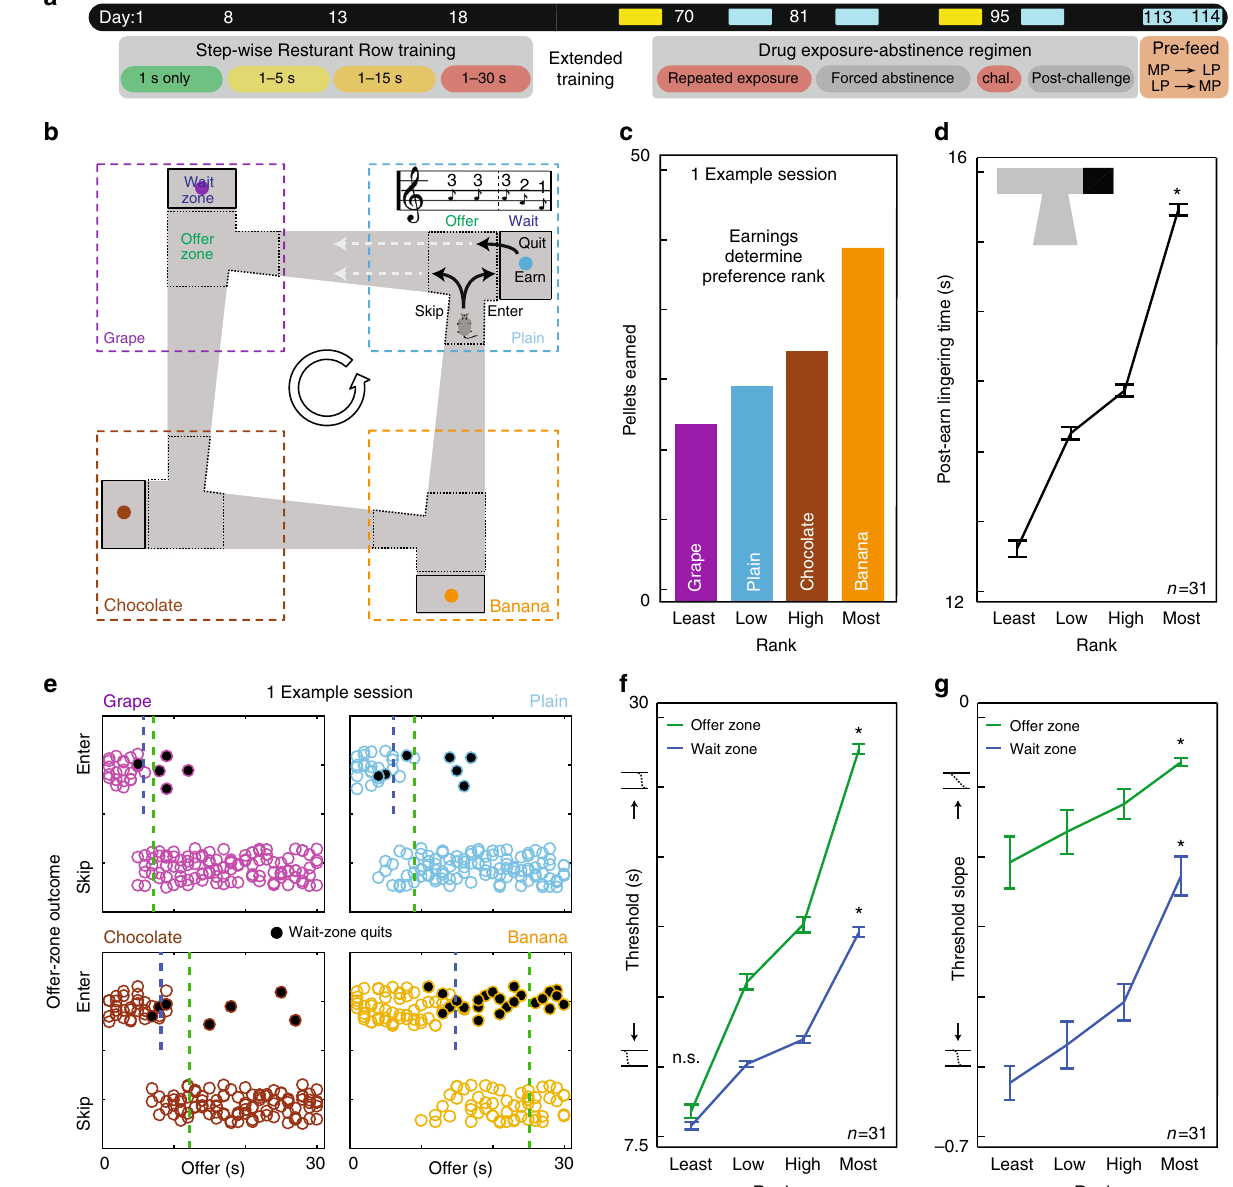
Fig. 1 Multiple valuations in Restaurant Row. a Experimental timeline. Timepoints of interest marked in yellow: well-trained at baseline (days 66 – 70, Figs. 1 and 2); after prolonged abstinence from repeated drug exposure (days 90 – 94, Fig. 3). Supplementary timepoints are marked in cyan. b Mice were trained to run counter-clockwise around a square maze encountering serial offers for fl avored rewards in four restaurants. Tone pitch indicated delay length that sounded in the offer zone, but did not countdown until after entering the wait zone. c Flavors were ranked from least- to most-preferred by end-of-session earnings each day. Panel shows one example session. Mice showed individual preferences that were stable across days (Supplementary Fig. 2). d Kruskal – Wallis (KW) tests revealed mice spent more time lingering at the reward site after earning rewards in more-preferred restaurants before moving on to the next trial (* P < 0.0001). e Mice entered low delays and skipped high delays in the offer zone, while infrequently quitting once in the wait zone (black dots). Dashed vertical lines represent calculated offer-zone and wait-zone thresholds of willingness to budget time. Green line indicates offer-zone threshold (all offers). Blue line indicates wait-zone threshold (entered offers). f KW tests revealed thresholds to enter (offer zone) and earn (wait zone) rewards were higher in more-preferred restaurants (* P < 0.0001). Post-hoc Dunn ’ s tests controlled for multiple comparisons revealed disparity between offer- and wait-zone thresholds was greater in more-preferred restaurants (* P < 0.0001), generating more enter-then-quit events (least-preferred, not signi fi cant, n.s., P > 0.05). g Slope of threshold fi ts were higher in the offer zone than wait zone and in more-preferred restaurants (KW test, * P <